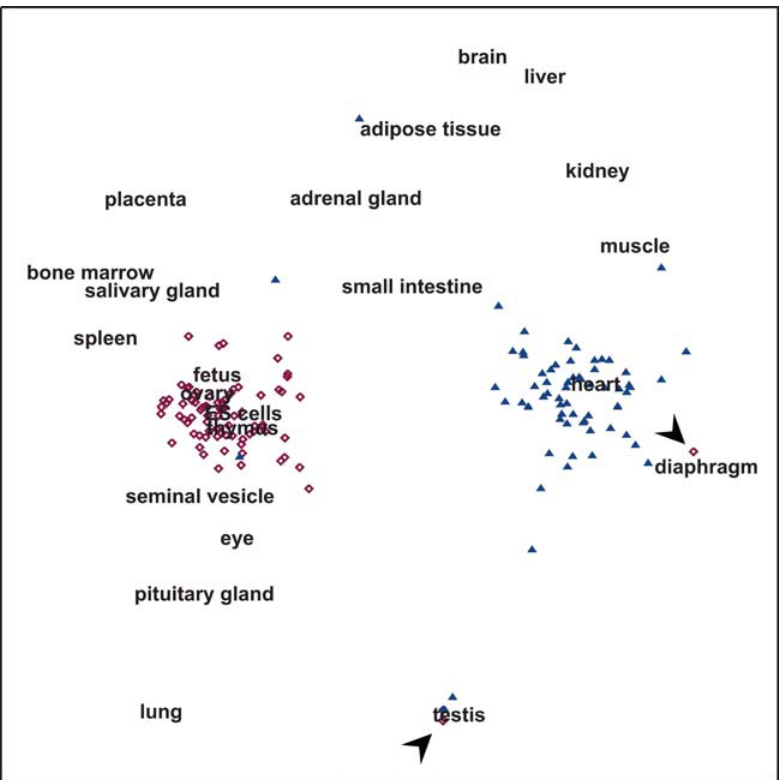
Figure 3. Multidimensional unfolding analysis of mRNA expression signals encoding 81 ribosomal proteins (purple symbols) versus 69 mitochondrial respiratory chain subunits (blue symbols). This analysis gives a graphical overview based on expression profiles; genes with a high expression in a certain tissue will be represented close to that tissue. Note that both groups of transcripts formed separate clusters. These clusters indicated high co-expression of ribosomal protein mRNA’s in tissues that are active in exocrine protein secretion and/or cell division. Respiratory chain mRNA’s were also co-expressed but were particularly high in striated muscle. Arrowheads indicate 2 ribosomal protein genes outside of the cluster. The upper arrowhead is Rpl3l , which clustered closely to the contractile tissues. The lower arrowhead is Rpl39l , located close to testis.